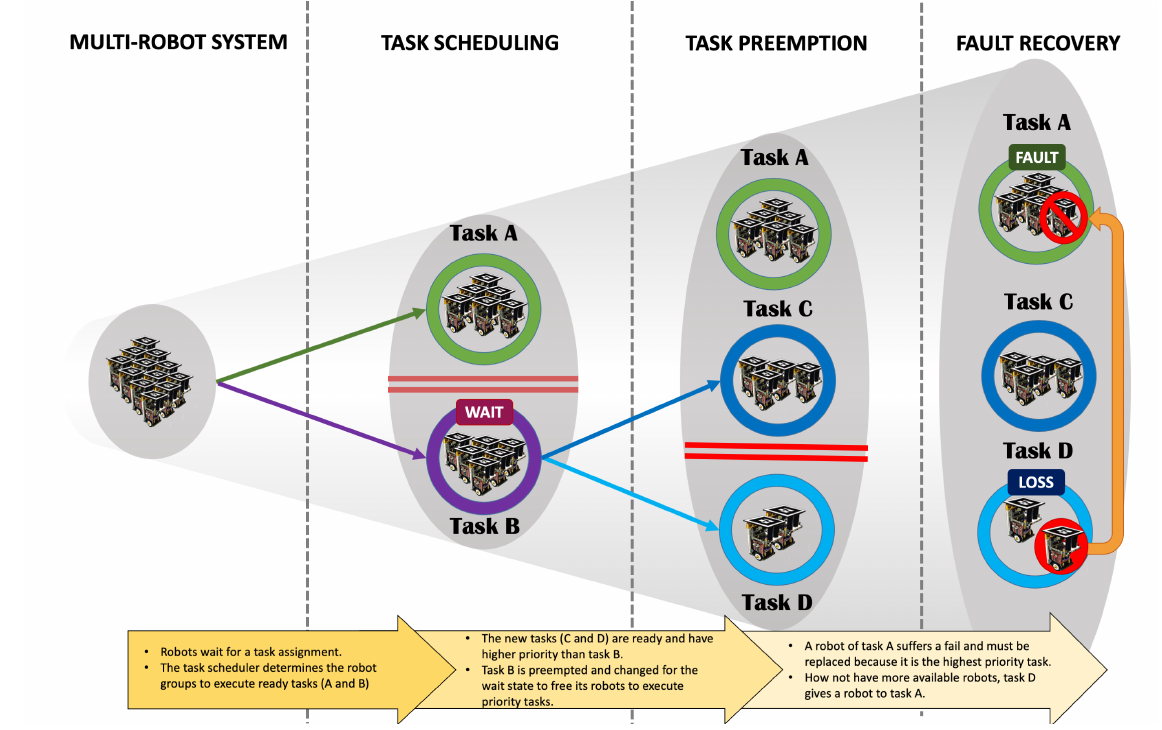
Figure 3. Overview of the MRPF with priority scheduling, task preemption, and fault